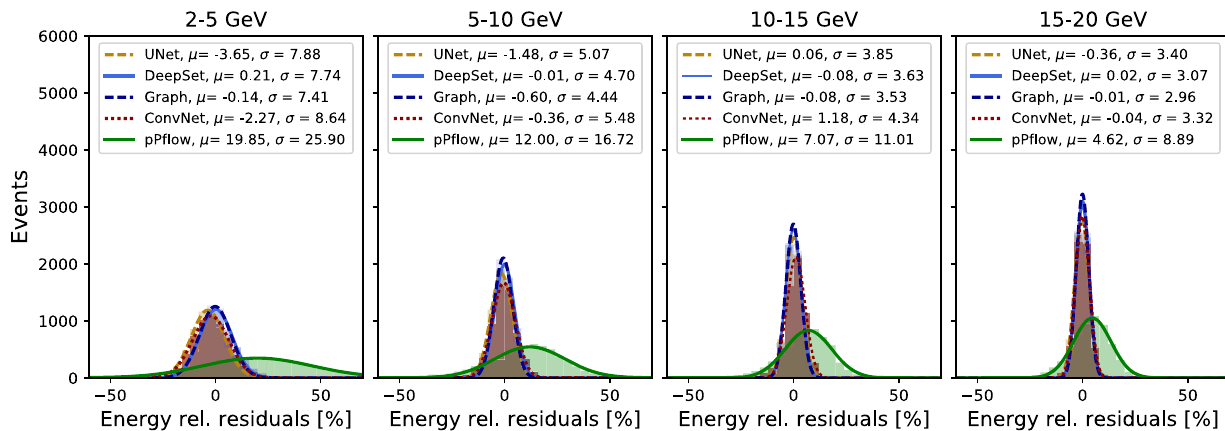
Fig. 5 The neutral energy relative residuals ( E predicted − E Neutral )/( E Neutral ) distributions of the pPflow and the different NN algorithms for different energy ranges described in the text. The distributions are fit with a sum of two gaussians to catch non-gaussian